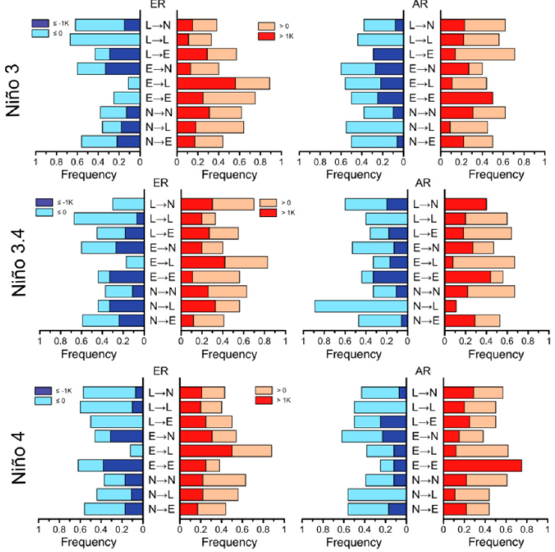
Figure 2. Frequency estimates of different positive ( δ T > 0 K—pink color; δ T > 1 K—red color) and negative ( δ T ≤ 0 K—blue color; δ T ≤ –1 K—dark blue color) SAT anomalies δ T for ER and AR in MJJ for different ENSO phase transitions from observations during 1891–2015 with the use of Niño3, Niño3.4 and Niño4 indices.